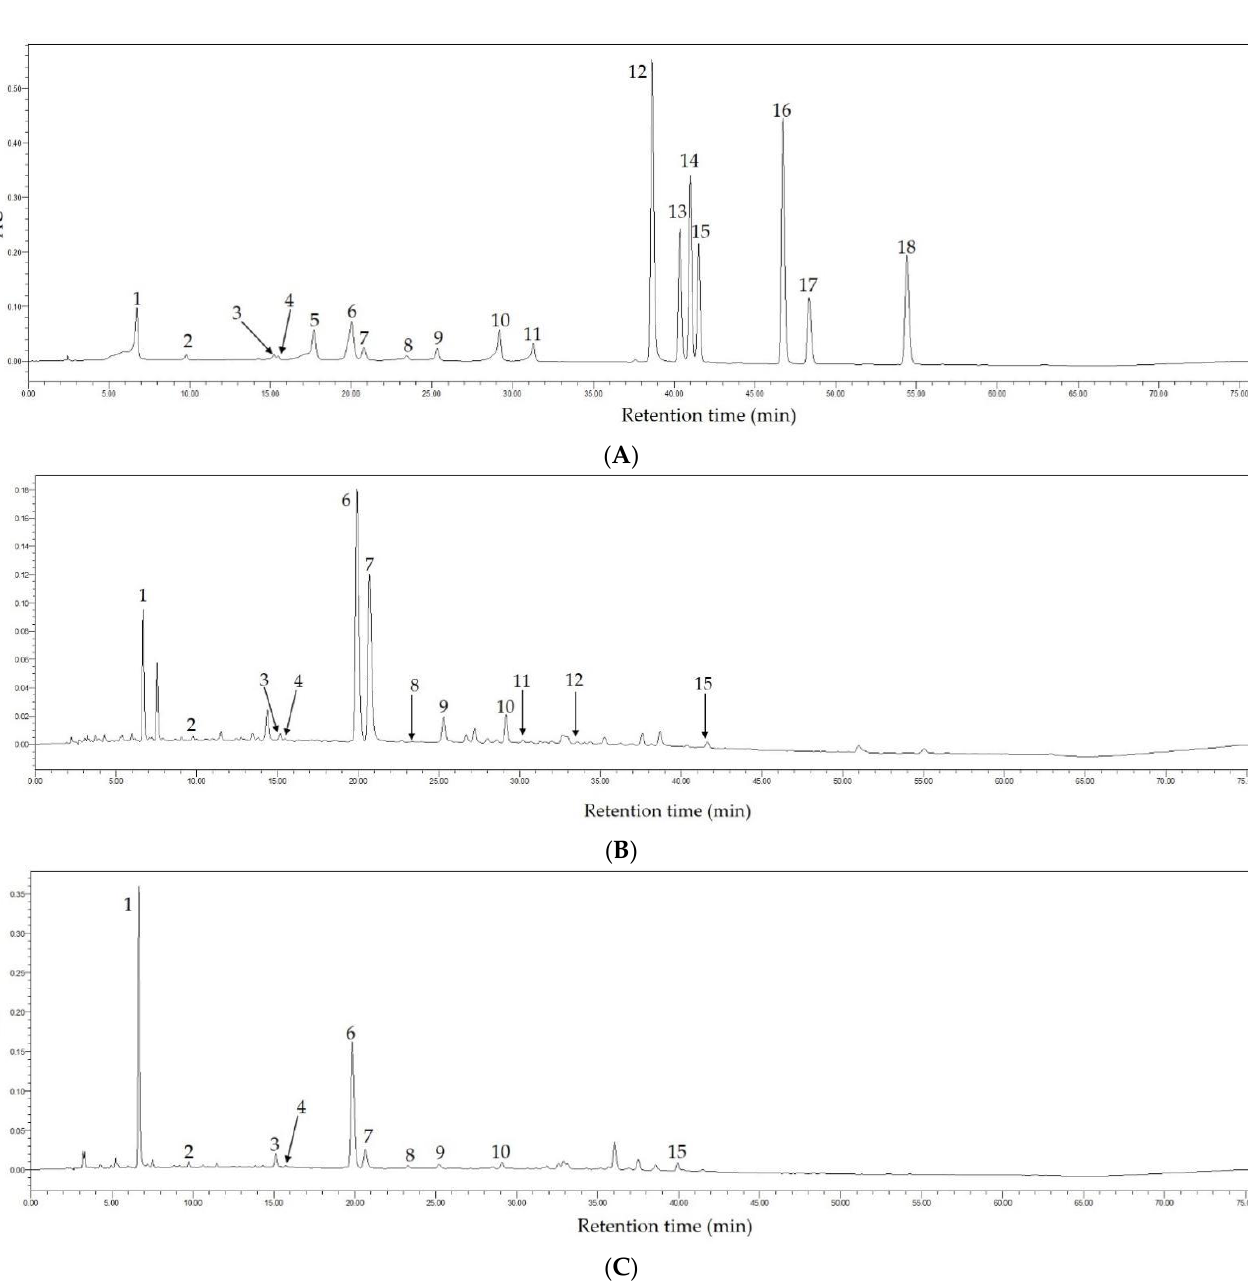
Table 3. The contents (mg/g DW) of main phytochemicals in Fenghuang Danzong and Selenium-Enriched Dark Tea.